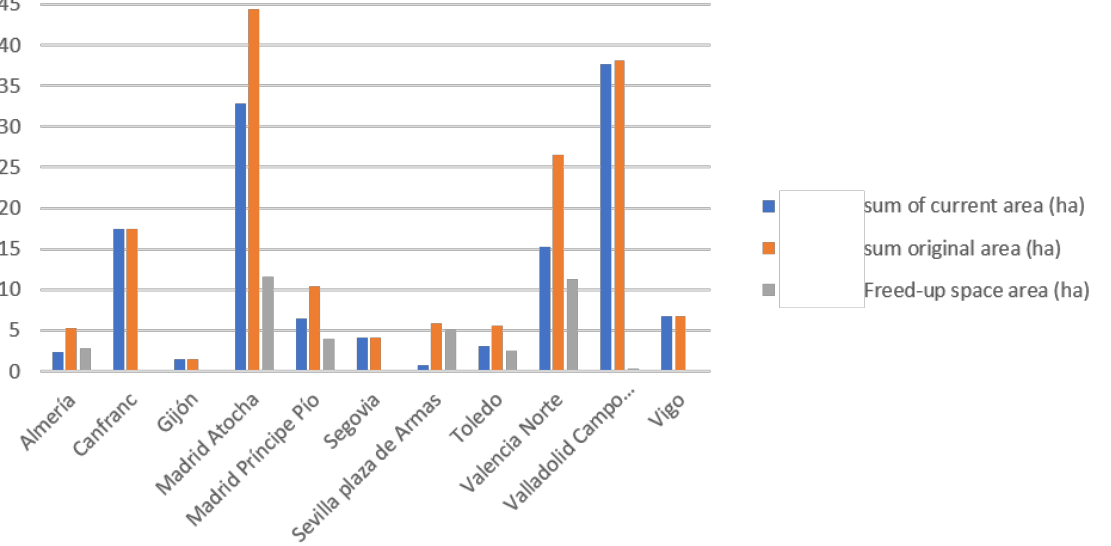
Figure 5. Original-current and released area stations. Own elaboration from National Geographic Institute (IGN) data (Iberpix display).